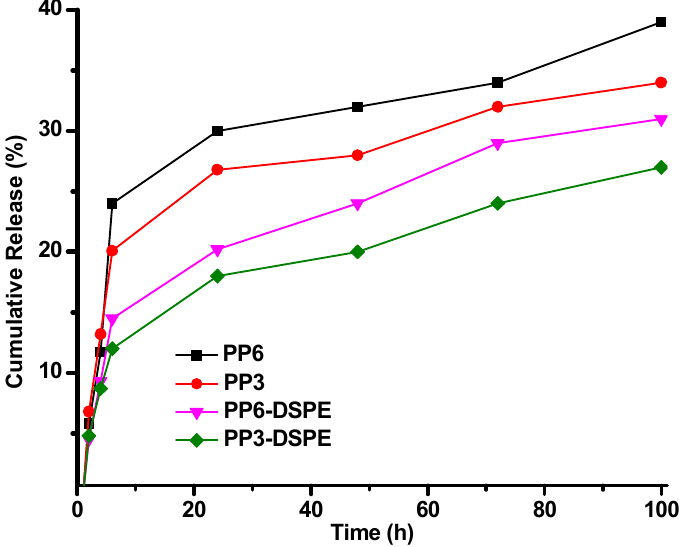
Figure 6. Release of AmB from micellar formulations measured for 100 h.